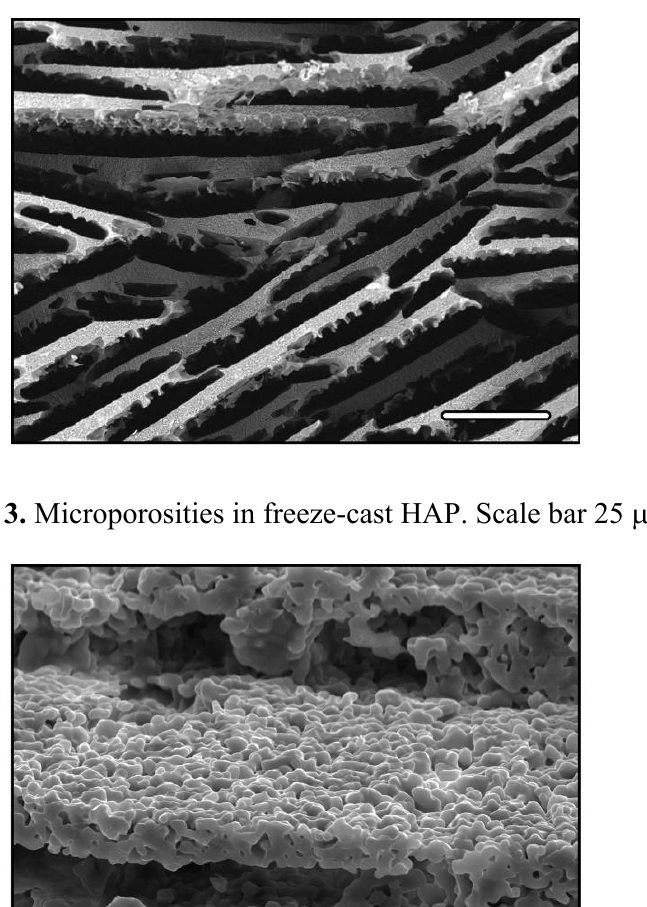
Figure 2. Macropores, freeze-cast alumina using water. Cross-section perpendicular to the solidification direction. Scale bar 100 μ m.